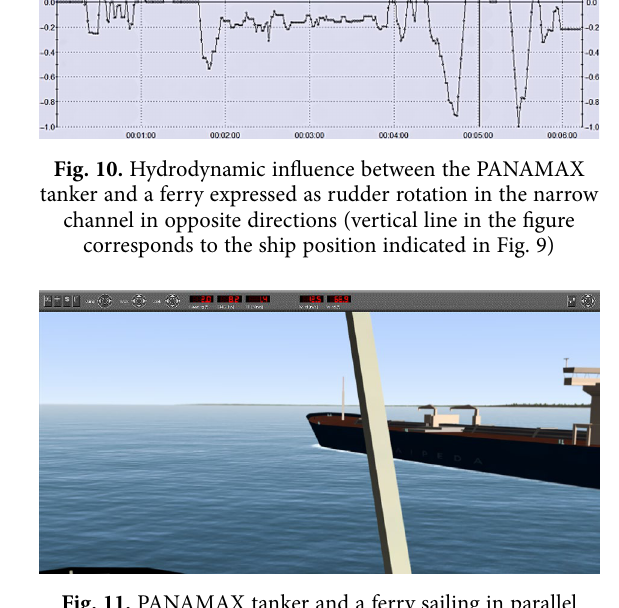
Fig. 11. PANAMAX tanker and a ferry sailing in parallel directions (speed of the PANAMAX tanker is 6 knots, speed of the ferry is 8 knots)